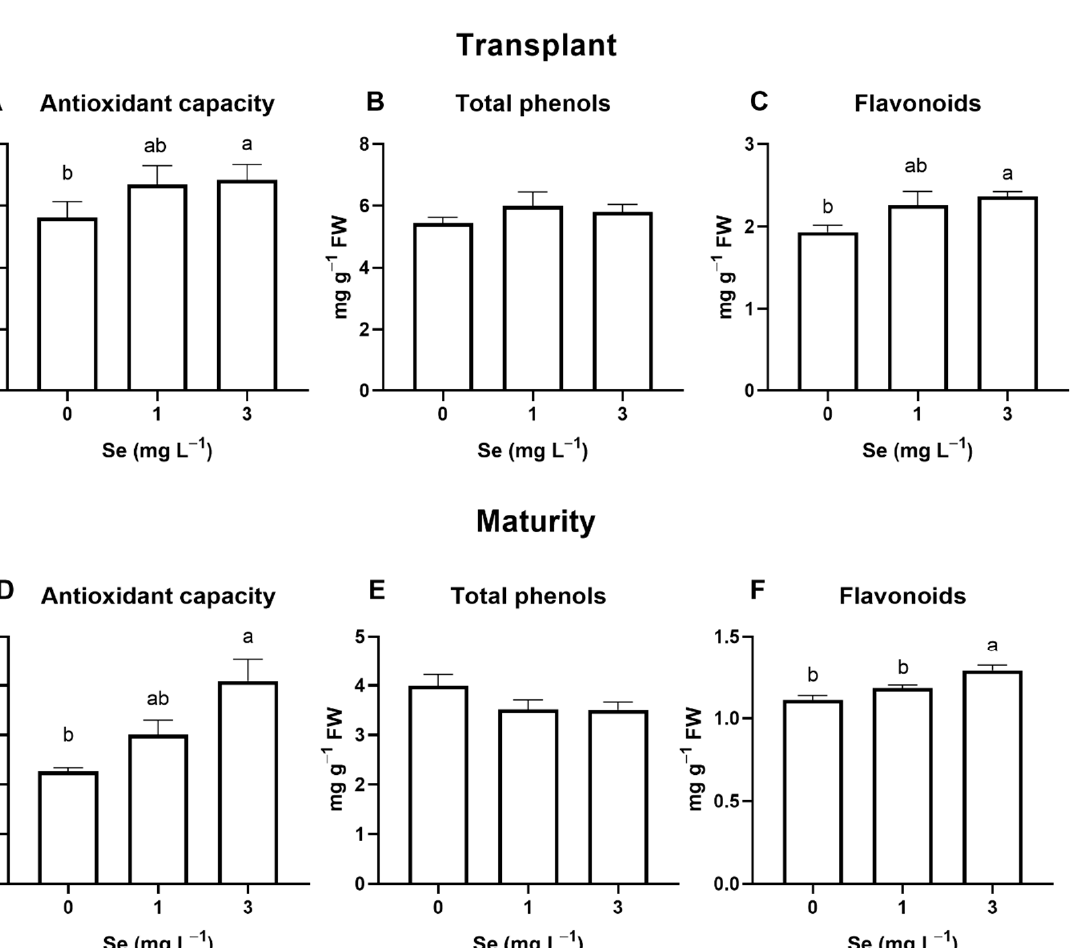
Means ( n = 3) flanked by the same letter are not statistically different for p = 0.05 after Tukey’s test. Significance level: ** p ≤ 0.01; * p ≤ 0.05; ns = not significant.